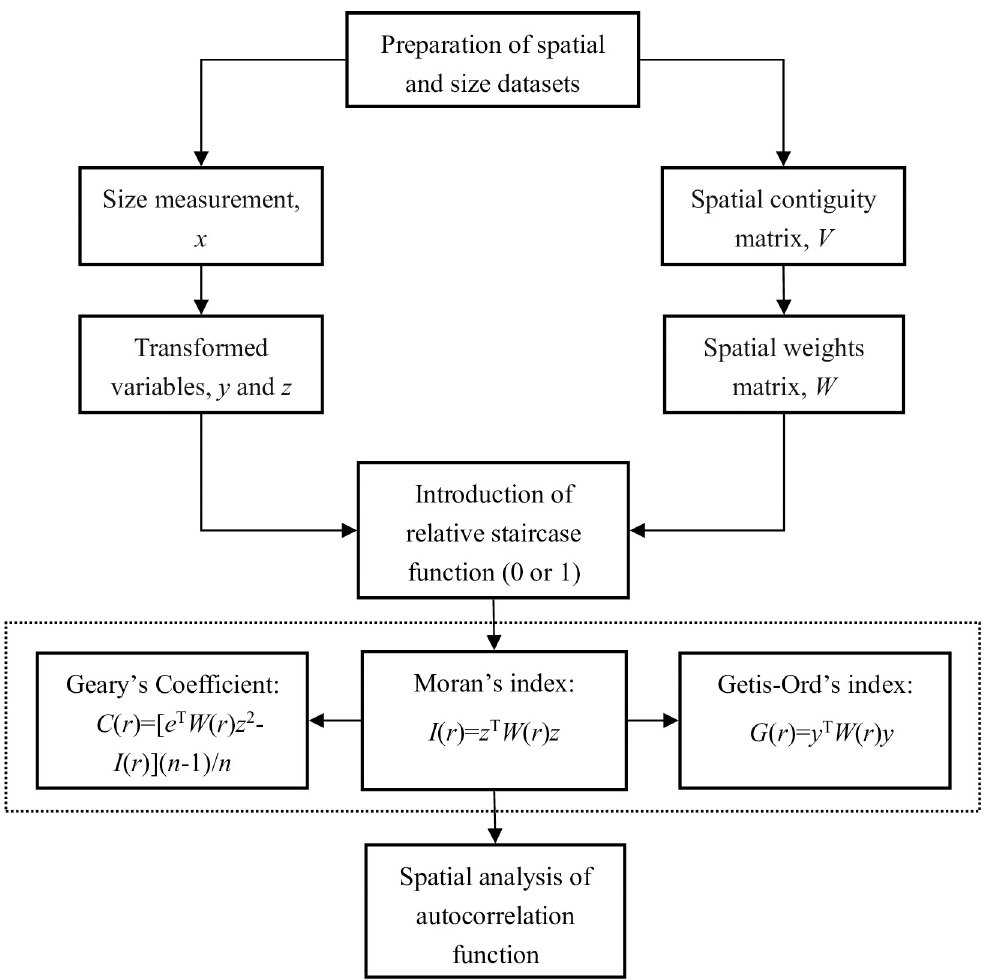
Fig 1. A flow chart of data processing, parameter estimation, and spatial autocorrelation function analyses. ( Note : The analytical process is based on the improved mathematical expressions of Moran’s I , Geary’s C and Getis-Ord’s G . Compared with x , y represents the unitized size variable, and z , the standardized